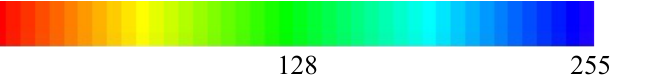
Figure 4. Correspondence between brightness and color tone for the color mapping.